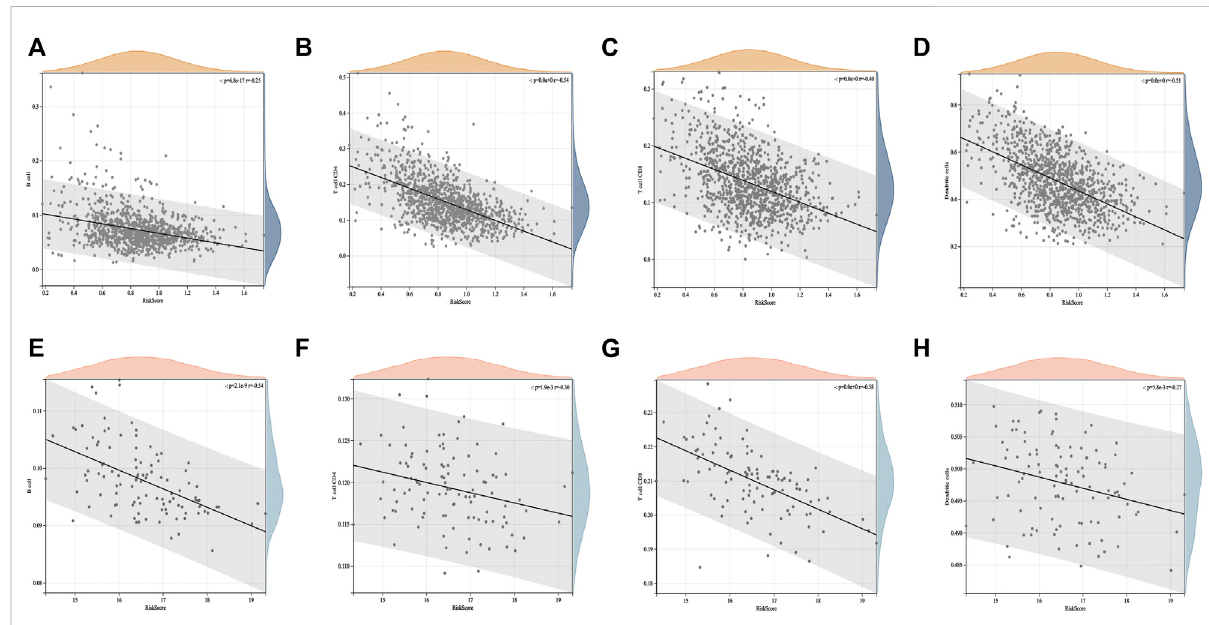
FIGURE 5 Correlation between the ICD risk model and tumor microenvironment. The scatter plots indicate that the ICD risk score is signi fi cantly negatively correlated with B cells, CD4 T cells, and CD8 T cells (A – D) , and further validation of the GEO cohort showed the same trend (E – H)